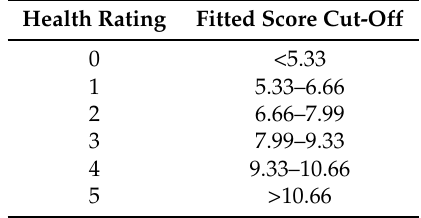
Table 3. Health Rating and their associated cut-offs from the GLM fitted